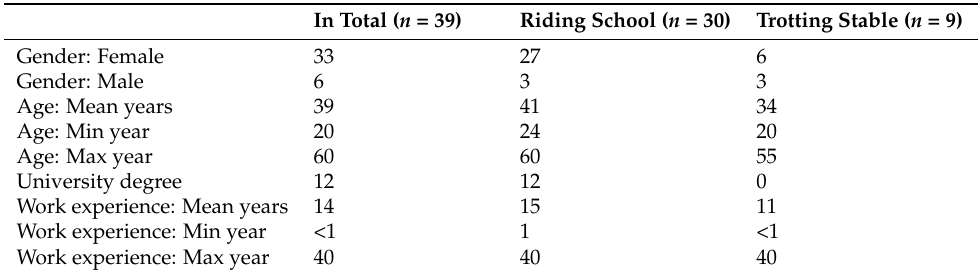
Table 1. Background information about the participants.